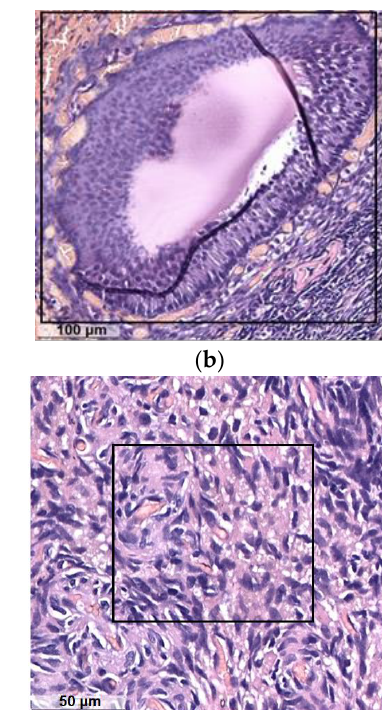
Figure 6. Histology of clinically healthy cat ovaries in the follicular phase: ( a ) primordial follicles; ( b ) primary follicle (1): granulosa of the follicle (2), shiny sheath of the follicle (3); ( c ) oocyte (1): granulosa of the oocyte (2), the shiny coat of the oocyte (3); ( d ) flattened follicular cells surrounding the oocyte.